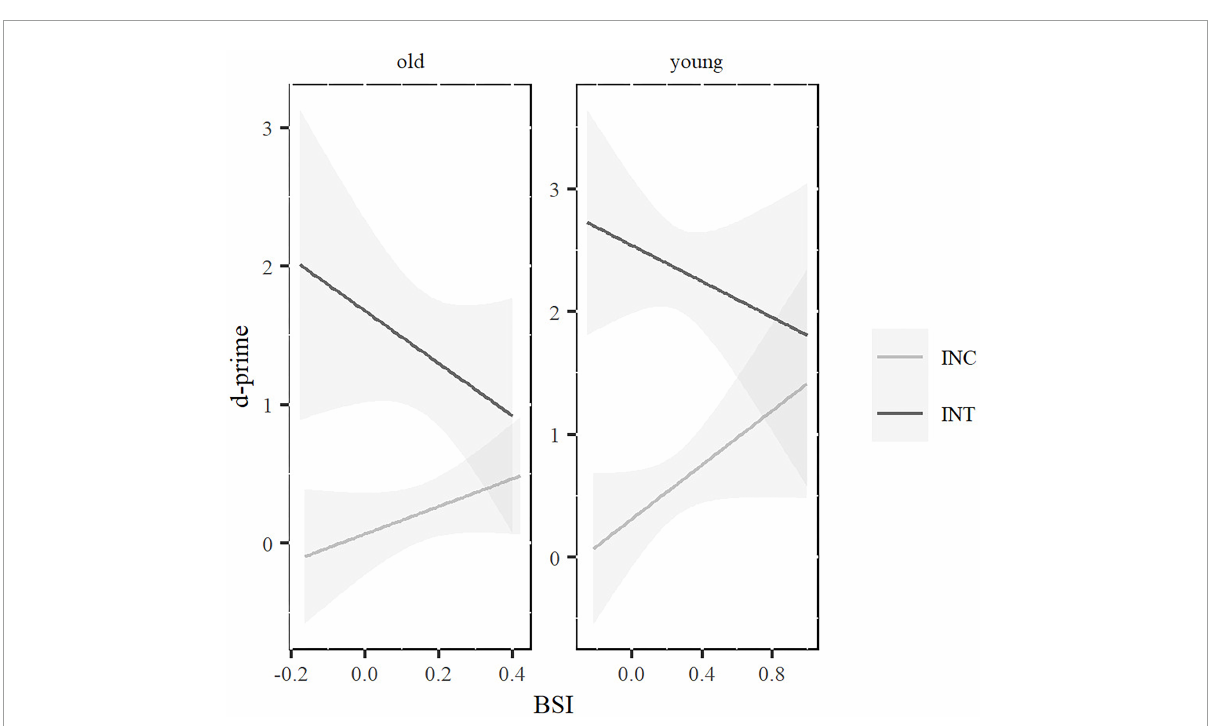
FIGURE3 Rule-learning d’ scores associated to BSI for incidental (INC) and intentional (INT) conditions, in younger (right) and older (left) adults. Highlighted areas represent Standard